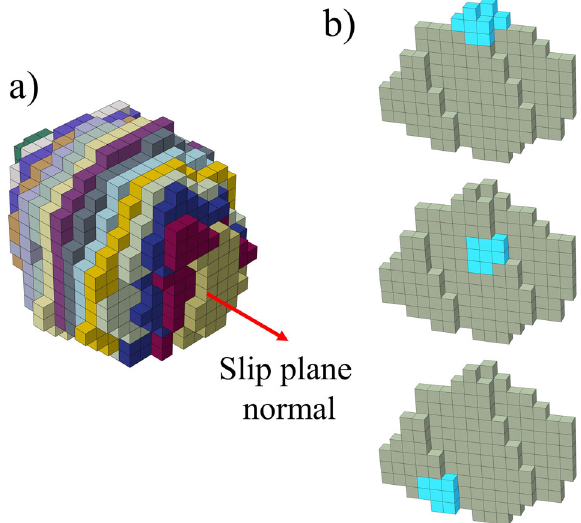
A single slip band from a in which different sub-band regions are highlighted for FIP volume averaging 25 .